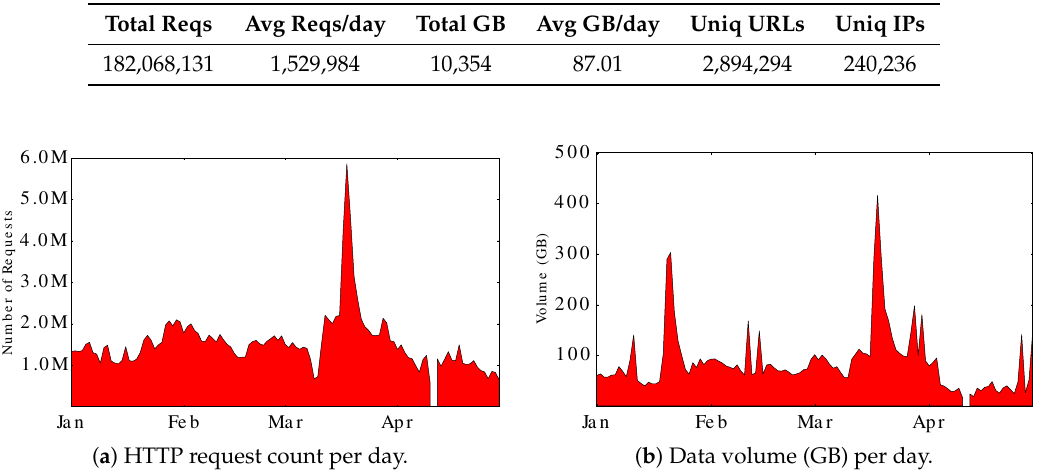
Table 2. Statistical characteristics of the aurora site (1 January 2015 to 29 April 2015).